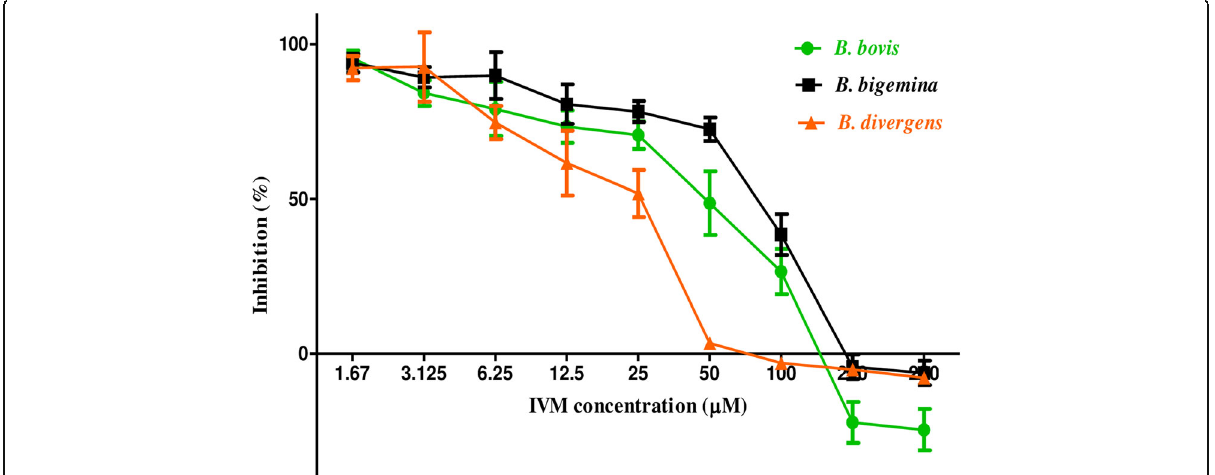
Fig. 1 The dose-response curves of ivermectin against bovine Babesia parasites in vitro. The curve shows the correlation between relative fluorescence units (RFUs) and the log concentrations of IVM ( μ M) in B . bovis , B . bigemina , and B . divergens treated with various concentrations of IVM. The result was determined by fluorescence assay after 96 h of incubation. The values obtained from three separate trials were used to